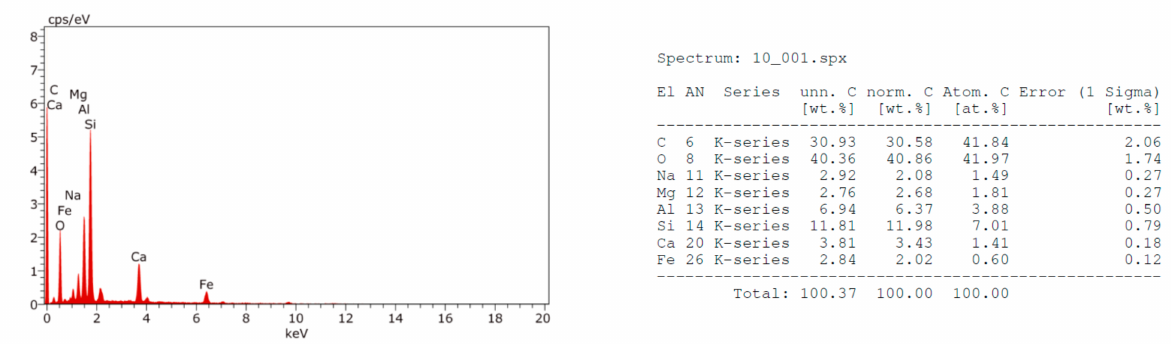
Figure 3. EDX analysis of Mix B fractured surface.